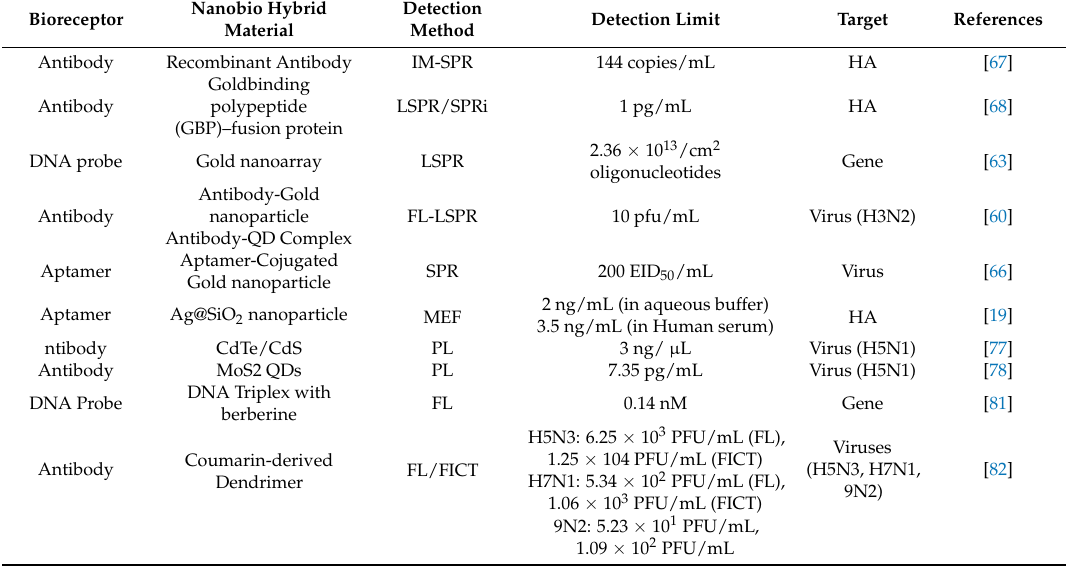
Table 2. Comparison of the localized-surface plasmon resonance (LSPR)-based biosensor and fluorescence (FL)-based for AIV detection in terms of receptor materials, nanobio hybrid material, detection method, detection limit and